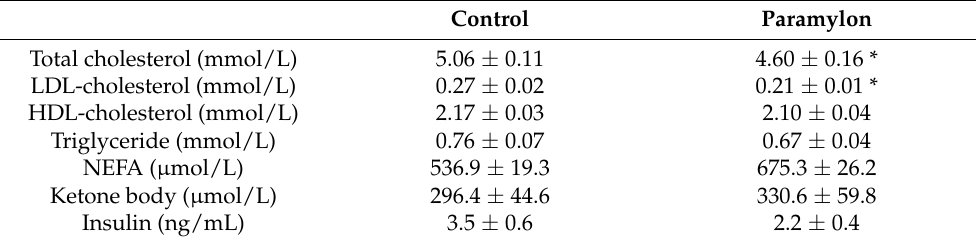
Table 4. Serum lipid and insulin concentrations.